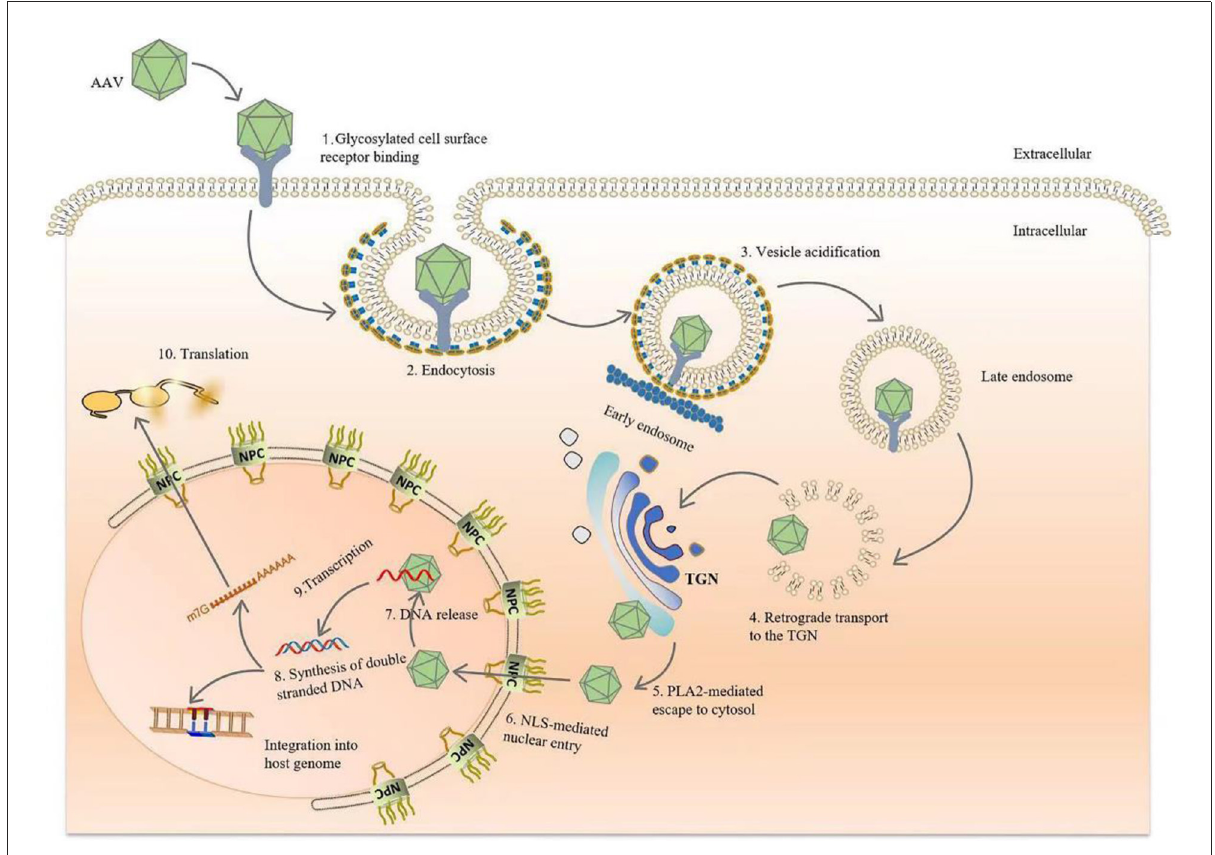
FIGURE2 Diagram of AAV transduction mechanism. AAV is bound by glycosylated receptors on the surface of host cells, initiating endocytosis, after which it is rapidly transported to the reverse Golgi apparatus (TGN). After arriving at the TGN, the conformations of VP1 and VP2 change due to the acidification of endocytic vesicles in the lower intracellular pH environment, and the phospholipase A2 domain of the capsid species is exposed. After endosomal escape, AAV crosses the Golgi membrane and enters the nucleus via a nuclear pour complex (NPC) guided by the nuclear localization sequence (NLS). Once in the nucleus, DNA is released from the capsid, and host cell DNA polymerase is used to rapidly initiate second-strand synthesis. Finally, viral genomes persistently express the transgenes. Vector genomes also integrate into the host genome to establish latency, although the probability of this event occurring is extremely